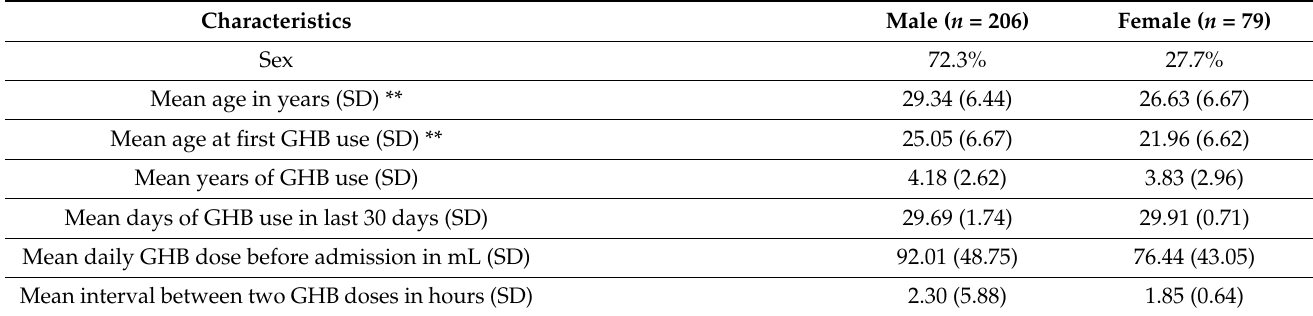
Table 1. Patients with GUD characteristics of unique patients ( n =